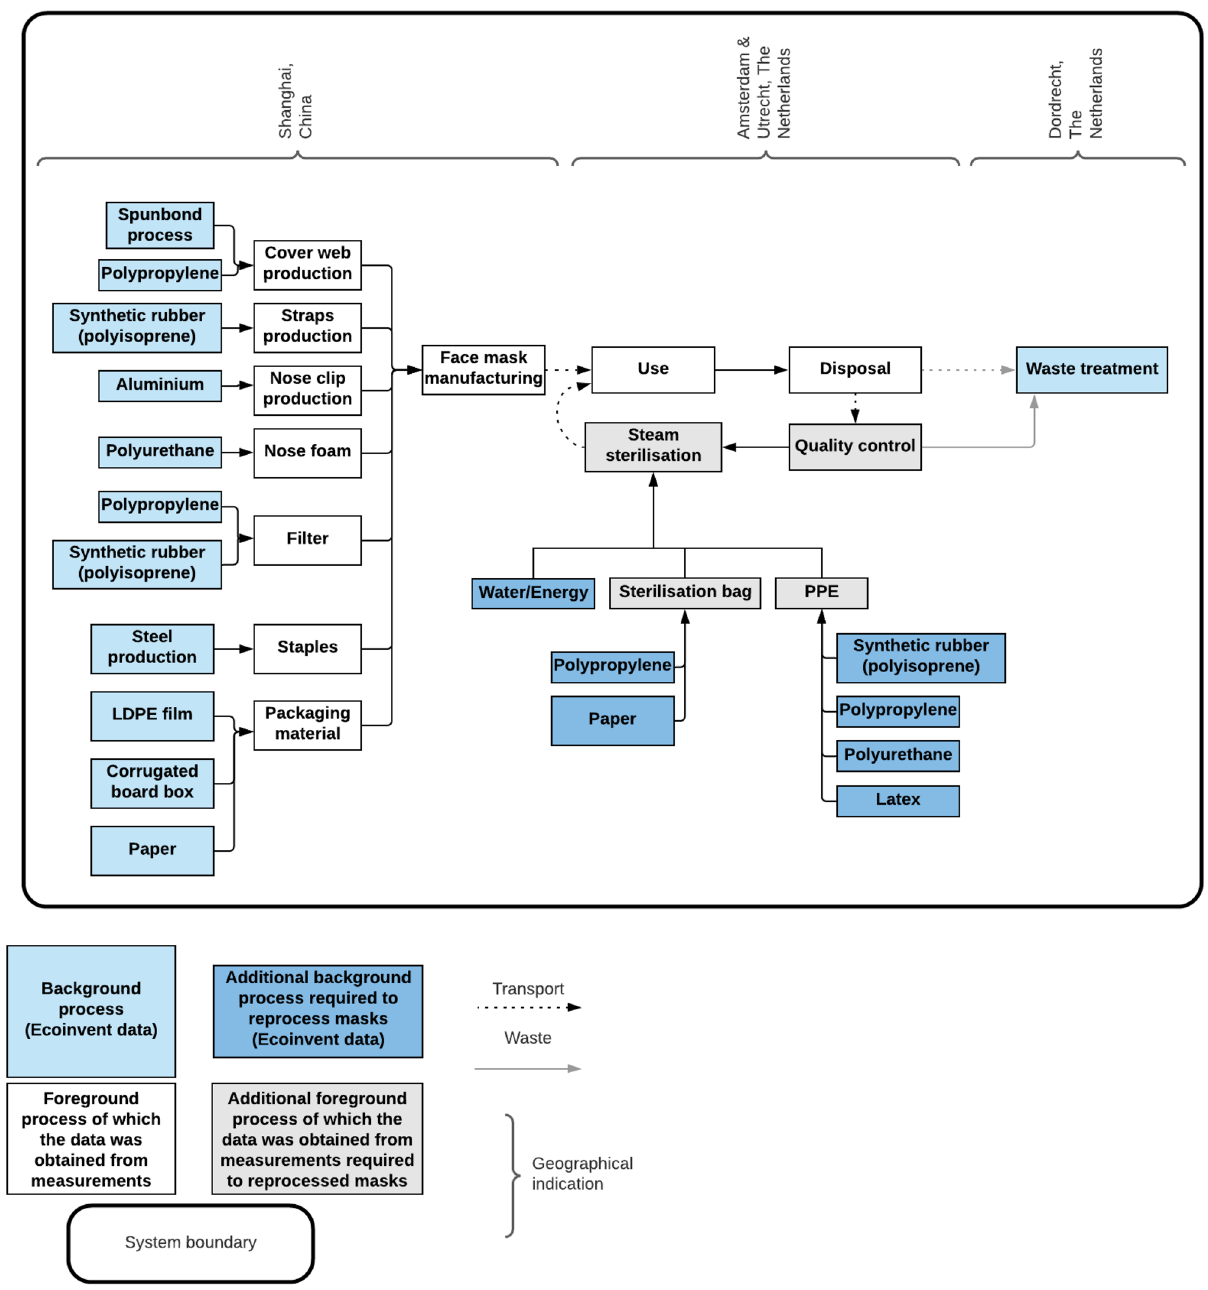
Figure 1. System boundary overview of new and reprocessed face masks including waste treatment by